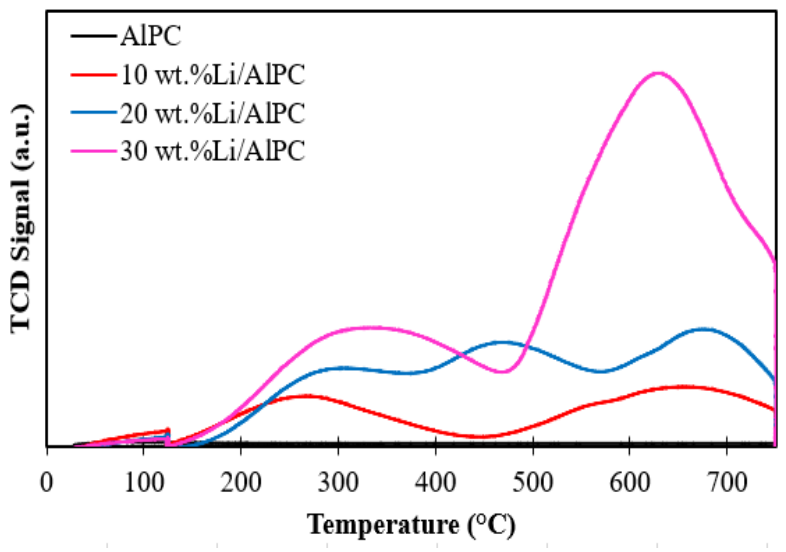
Figure 6 . CO 2 -TPD profiles of AlPC and x wt.%Li/AlPC ( x = 10, 20, and 30 wt.%) catalysts . Figure 6. CO 2 -TPD profiles of AlPC and x wt. %Li / AlPC ( x = 10, 20, and 30 wt. %)